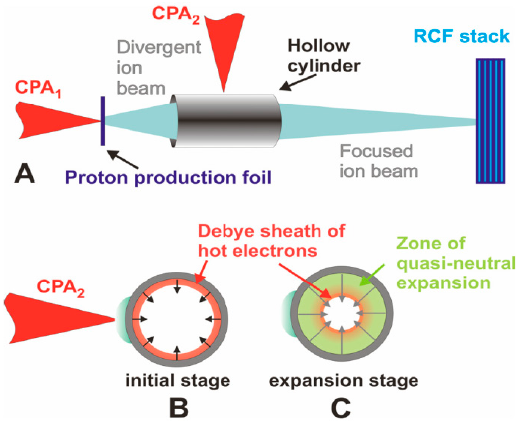
Figure 10. An ultrafast laser-driven microlens to focus and energy select MeV protons. This technique is in principal scalable to high-energy protons. Reproduced from [55].